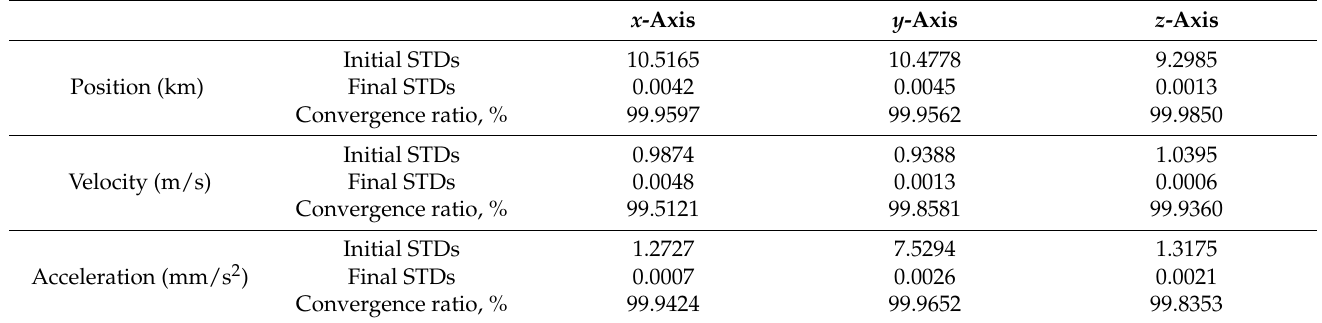
Figure 12. Monte Carlo simulations results using the eighth-order polynomials. Table 4. Convergence ratios of the method using the eighth-order